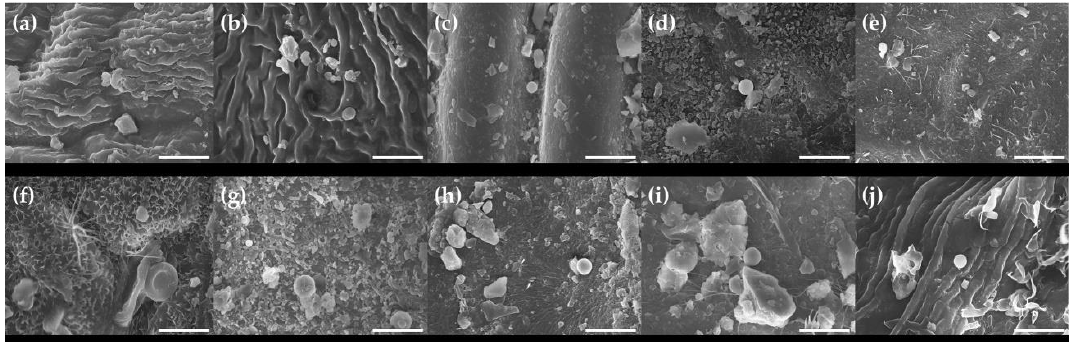
Figure 8. Surface images by utilizing the scanning electron microscope (SEM) on micro-roughness of adaxial leaf surfaces of ten species in urban forests: ( a ) Aesculus turbinata ; ( b ) Chionanthus retusus ; ( c ) Ginkgo biloba ; ( d ) Liriodendron tulipifera ; ( e ) Magnolia denudata ; ( f ) Styphnolobium japonicum ; ( g ) Taxus cuspidata ; ( h ) Buxus koreana ; ( i ) Euonymus japonicus ; ( j ) Rhododendron schlippenbachii . Note: Images show different roughness scales, waxes, and PM adsorption conditions on adaxial leaf surfaces. Scale bars: 10 μm.